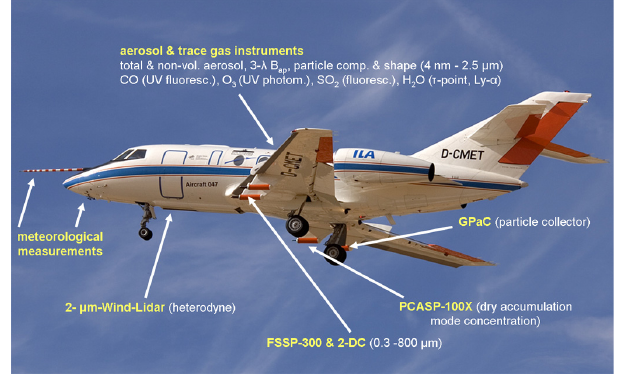
Fig. 1. DLR-research aircraft Falcon and its instrumentation dur- ing the volcanic ash flights (Photo: Sergio Domingos, http://www.